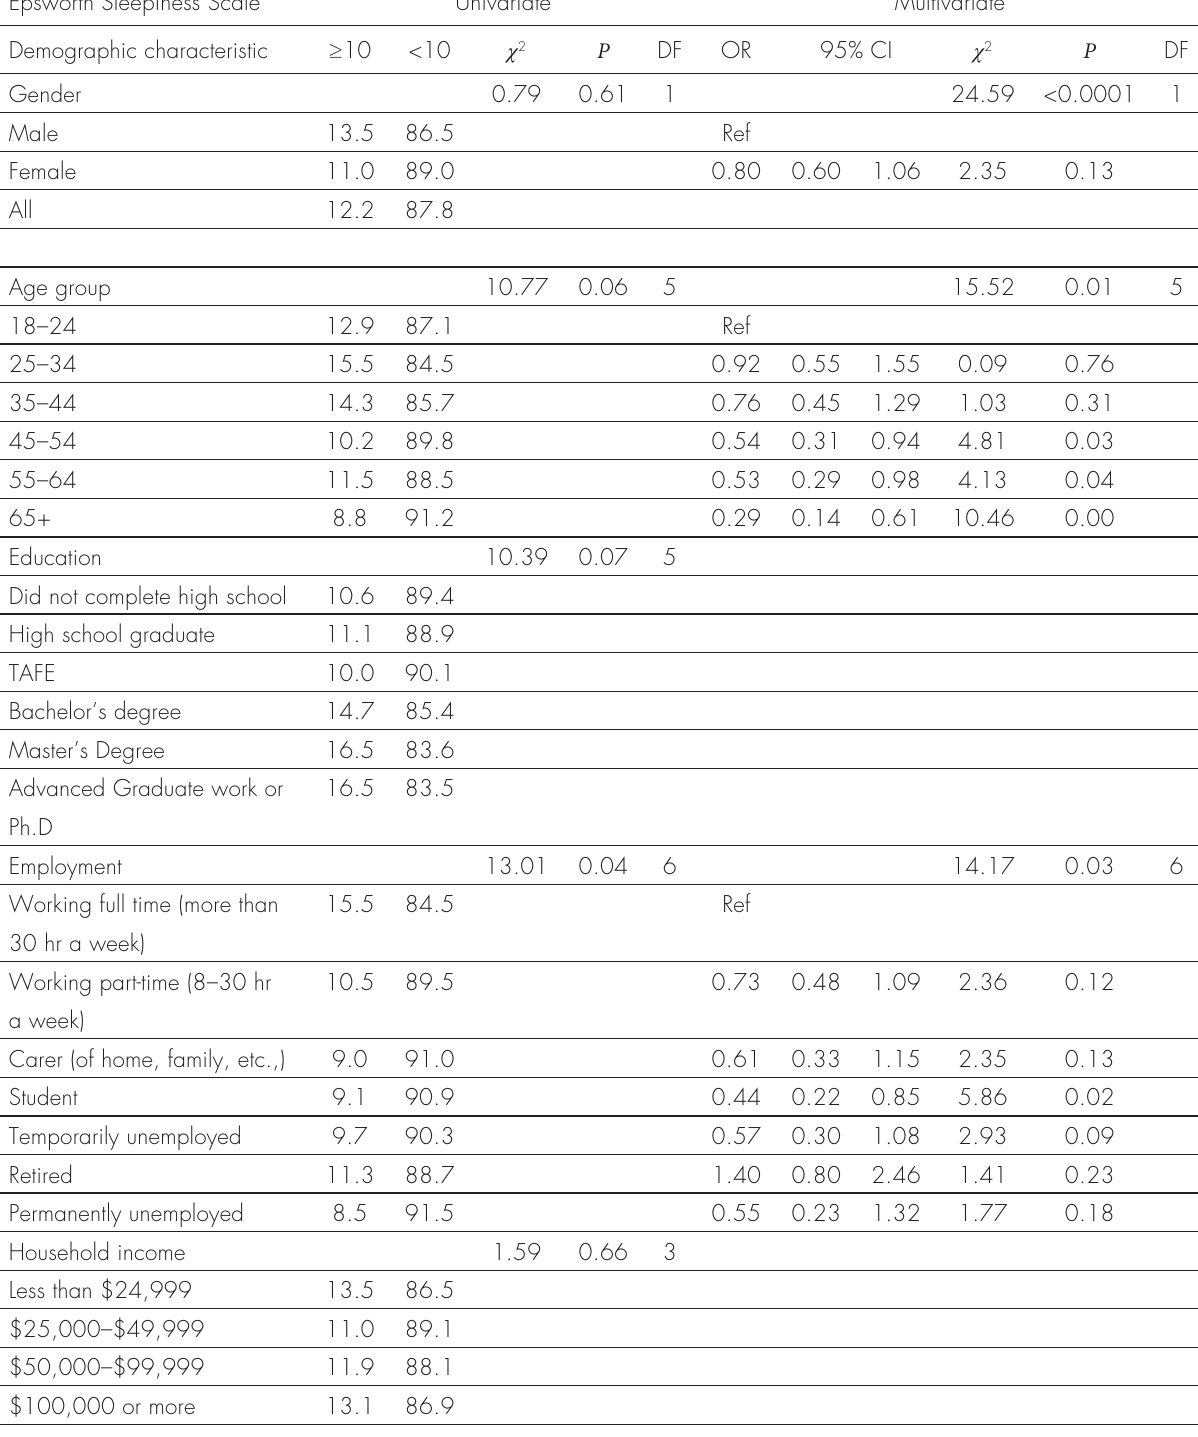
Table V. Demographic characteristics (gender, age group, education, employment status, annual income) and their associations with significant Epsworth Sleepiness